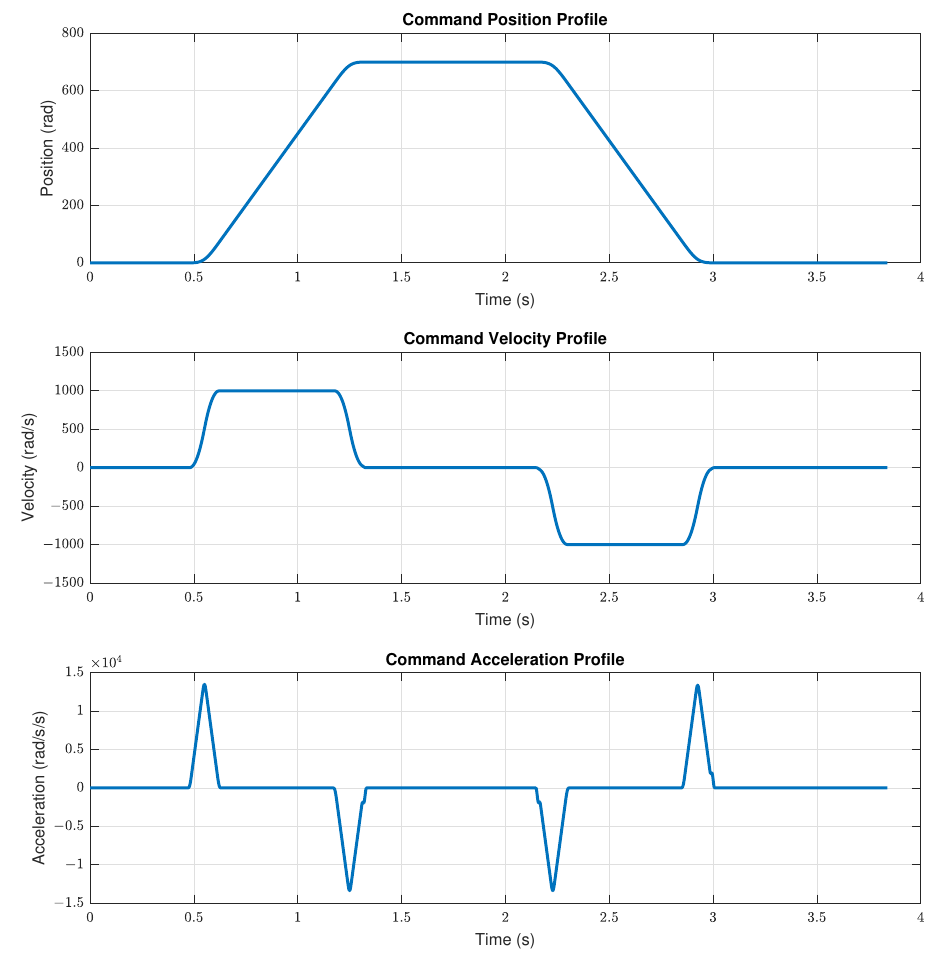
Figure 6. Point-to-pointmotion profile. Table 3. Plant